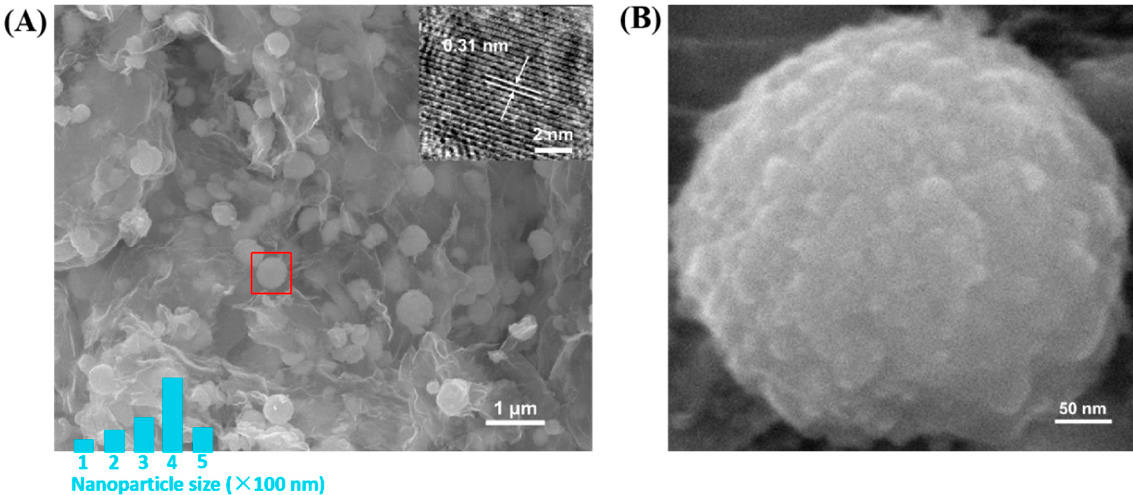
Figure 3. SEM images ( A , B ) of Co 0.6 Ni 0.4 S 2 /rGO, and the inset pictures in picture ( A ) are the size distributions of Co 0.6 Ni 0.4 S 2 particles and HRTEM images.